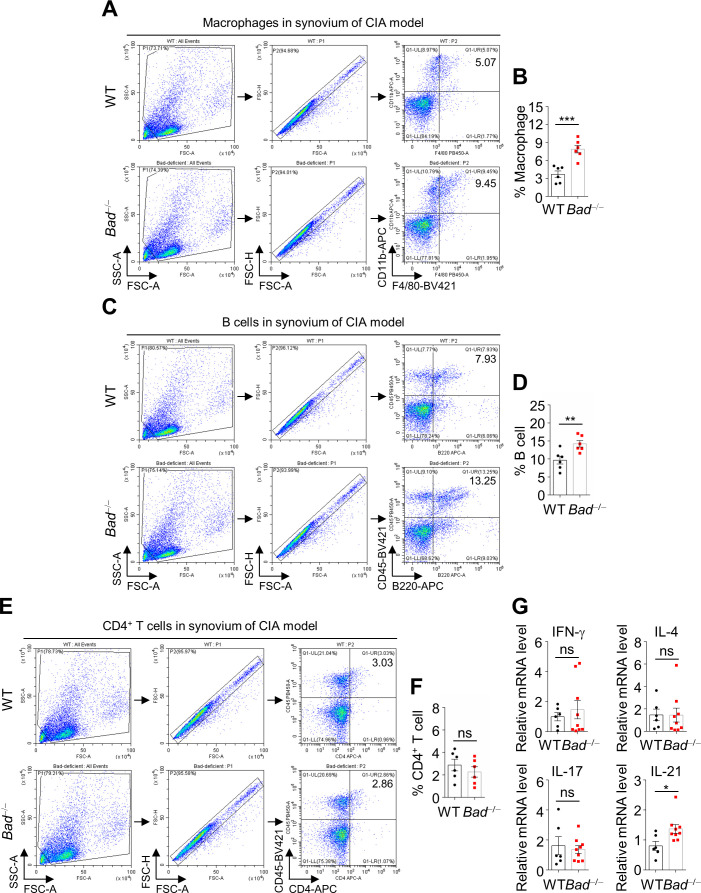
The percentages of macrophage, B cell, and CD4+ T cell in synovium of wild-type (WT) and Bad−/− mice in collagen-induced arthritis (CIA) model.(A, C, and E) The percentages of macrophage (CD11b+ F4/80+) (A), B cell (CD45+ B220+) (C), and CD4+ T cell (CD45+ CD4+) (E) in the synovium of WT and Bad−/− mice in CIA model were determined by flow cytometry. (B, D, and F) Quantification of the percentages of macrophage (B), B cell (D), and CD4+ T cell (F) in the synovium of WT (n = 6) and Bad−/− (n = 6) mice in CIA model. (G) Relative mRNA expression levels of cytokines secreted by CD4+ T cell subtypes in the joints of WT (n = 6) and Bad−/− (n = 9) mice in CIA model. All data are presented as mean ± SEM; dots represent individual mice. Significant difference was analyzed by unpaired Student’s t-test, *p<0.05; **p<0.01; ***p<0.001.